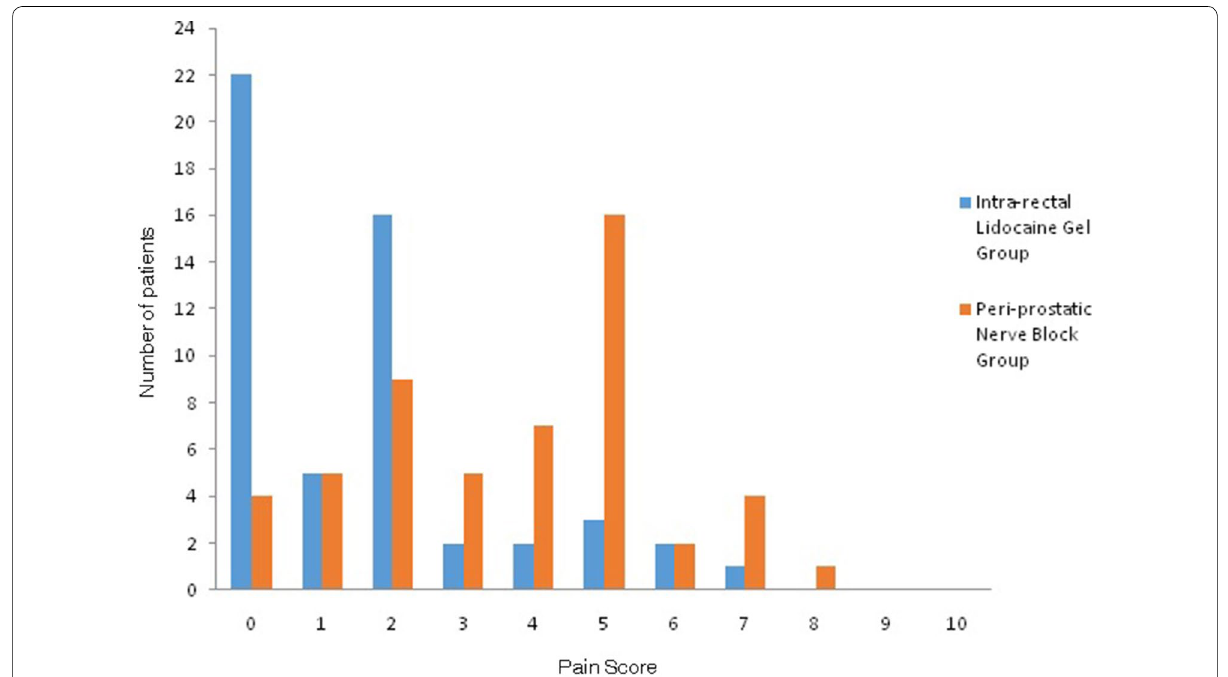
Fig. 2 Pain score during anaesthetic administration in the intra-rectal lidocaine gel and peri-prostatic nerve block